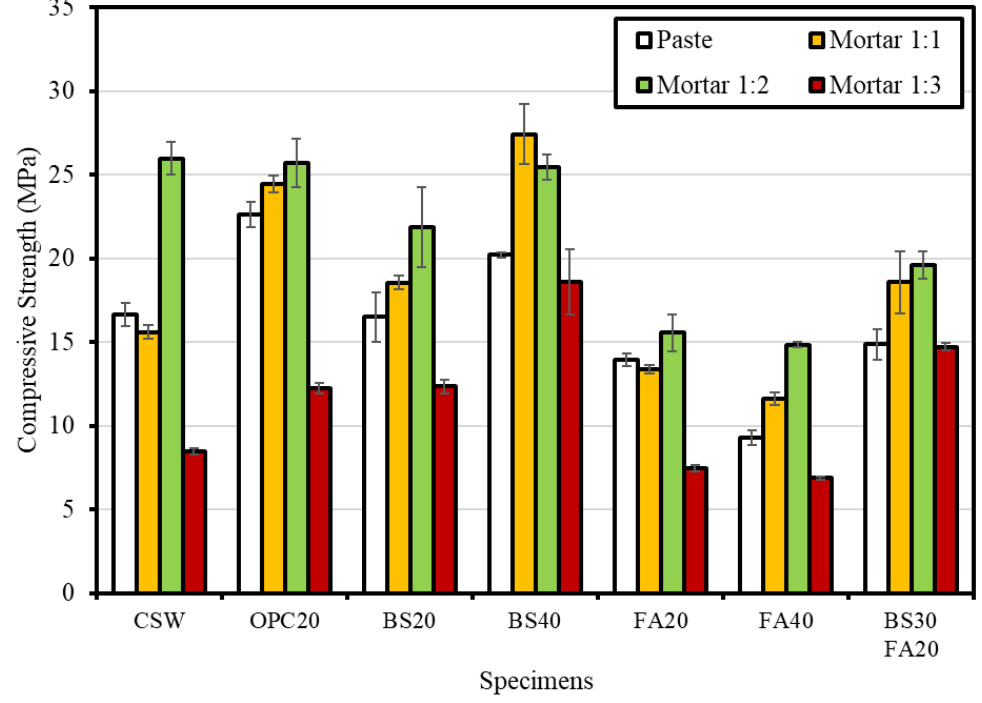
Figure 6. Compressive strength measurement results.